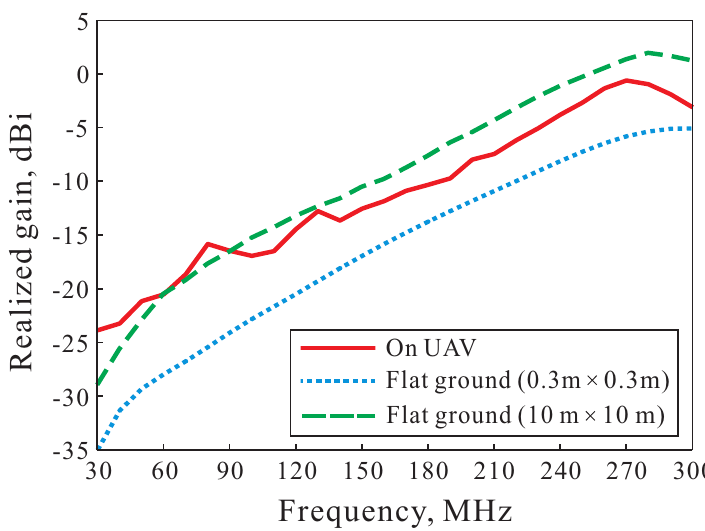
Figure 10. Simulated realized peak gains of the proposed antenna on a UAV and on flat ground.